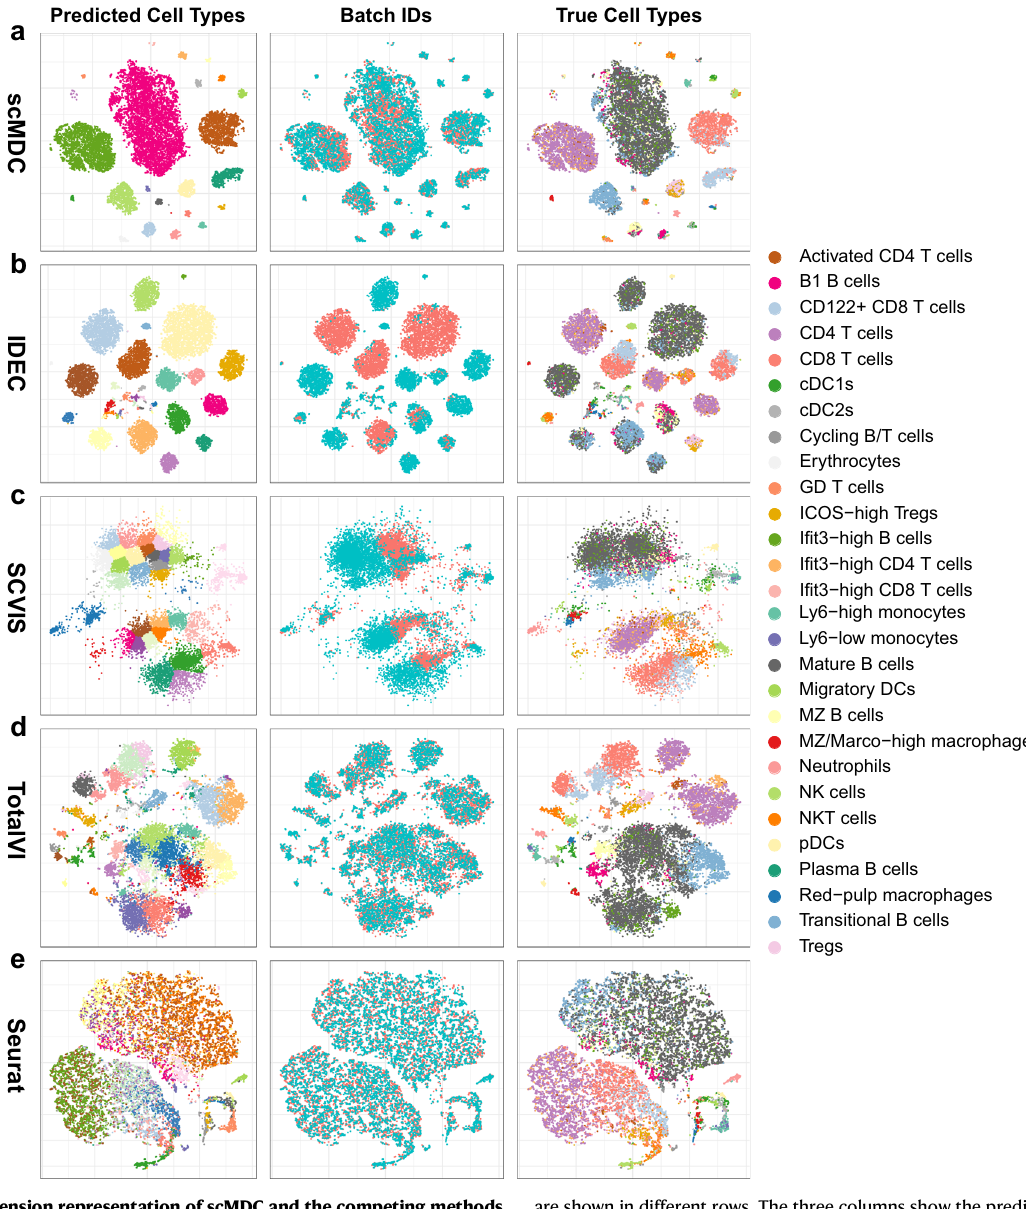
are shown in different rows. The three columns show the predicted labels, batch IDs, and true labels on the latent space learned from each